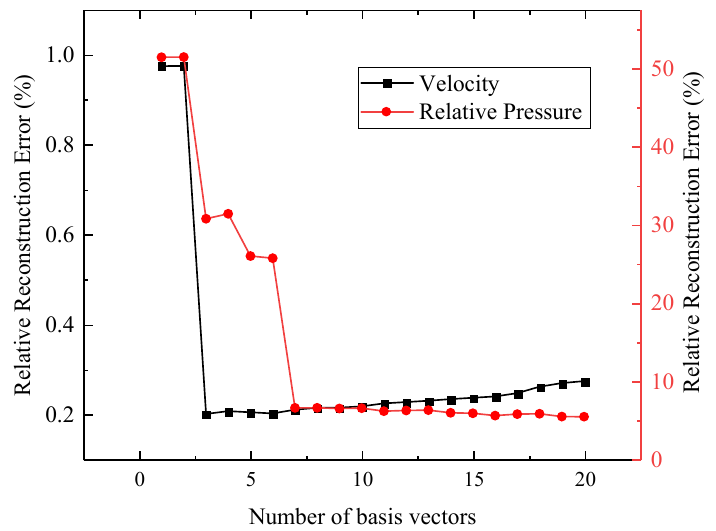
Figure 7. Relative reconstruction error (%) corresponding to different number of basis vectors.